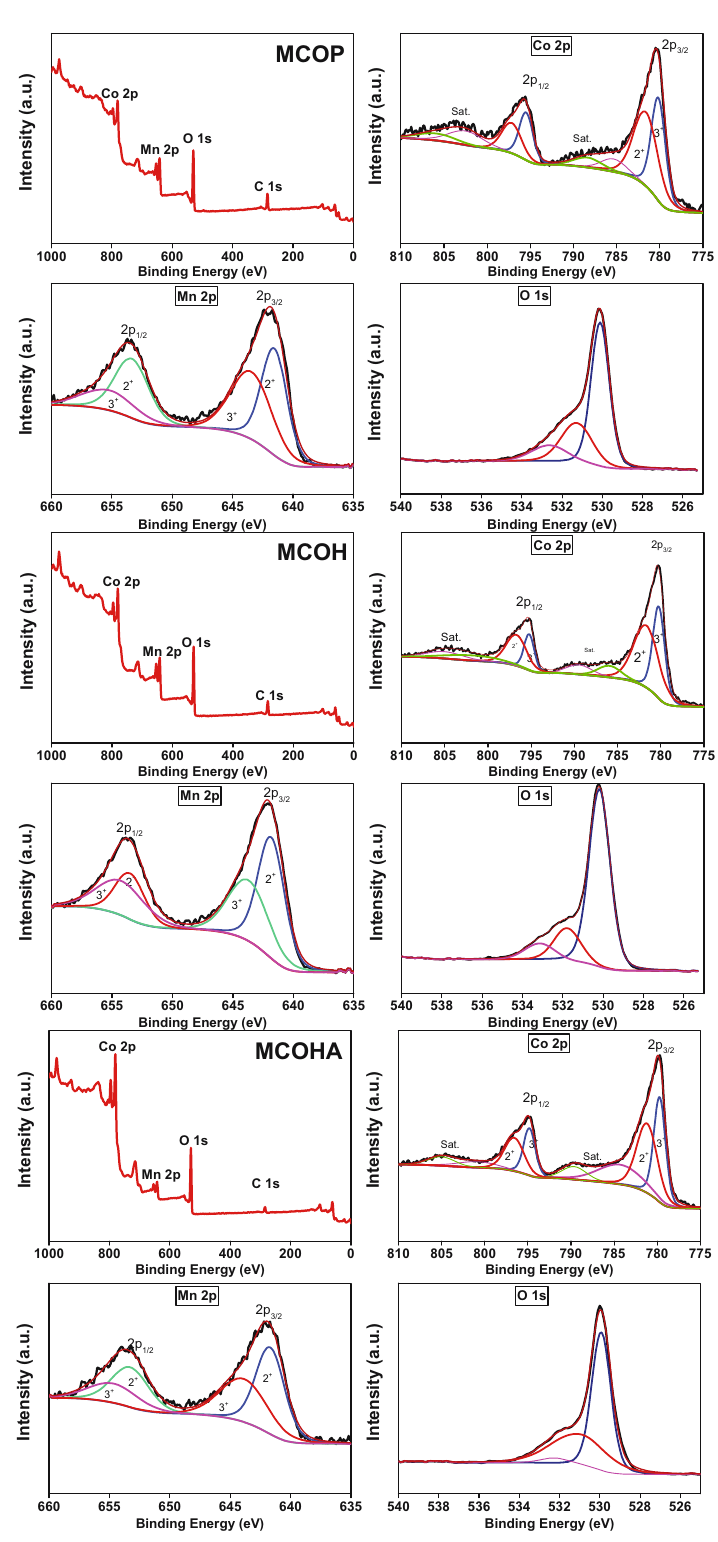
Figure 4: XPS spectra of the MCO samples: The survey spectrum and high - resolution spectra of Co 2p, Mn 2p, and O